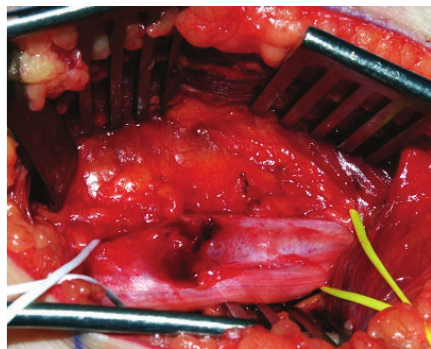
Figure 2: Intraoperative photo of Ewing’s sarcoma arising from the tibialsegmentoftherightsciaticnerve(controlledwithslings)inthe mid-thigh. The areas of necrosis as well as the irregular shape of the lesion clearly differentiate it from the appearances of a